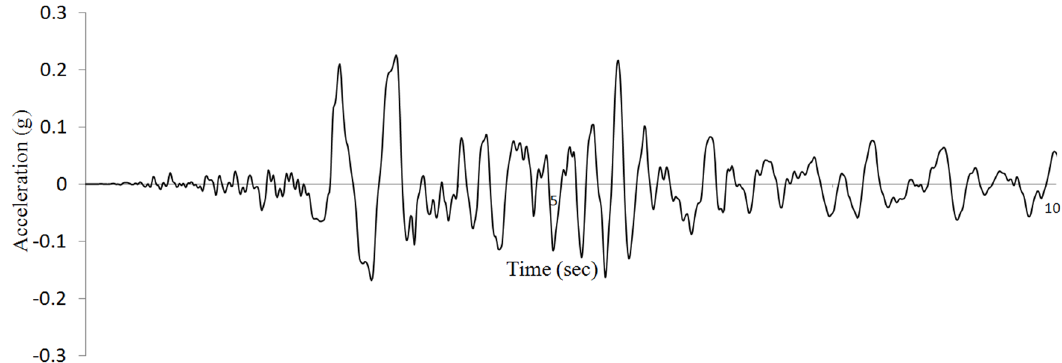
Figure 8. Base input motion (Acceleration record of Kobe (1995) earthquake scaled to 0.22 g).